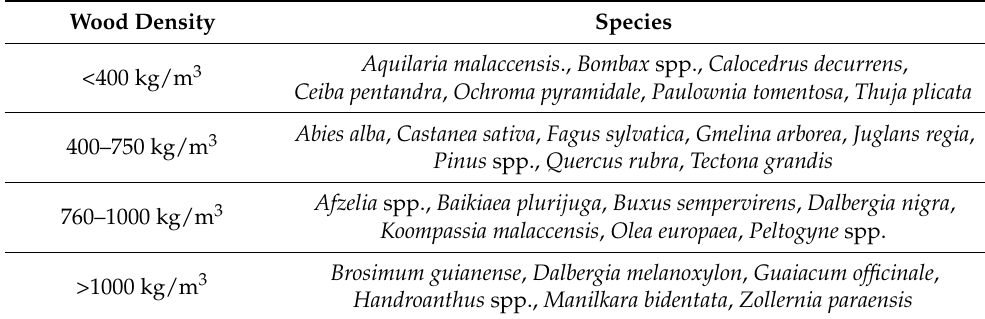
Table 18. Examples of species for different wood density classes.